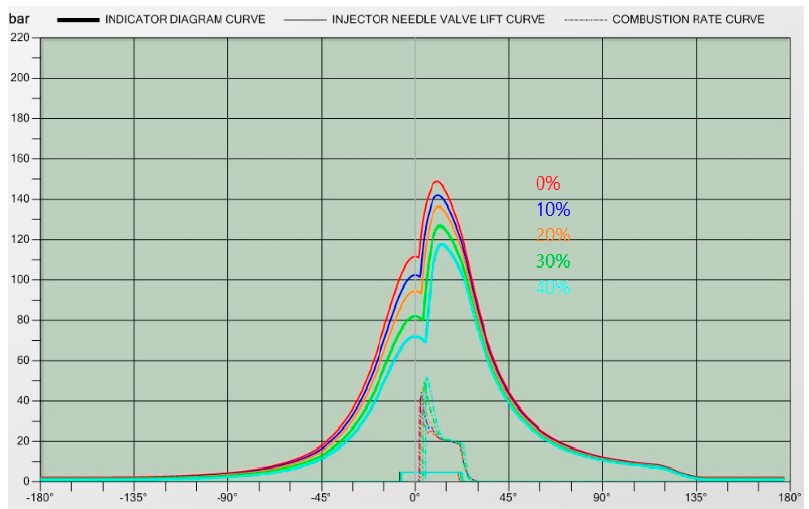
Figure 4. Indicator diagram during air filter faults.